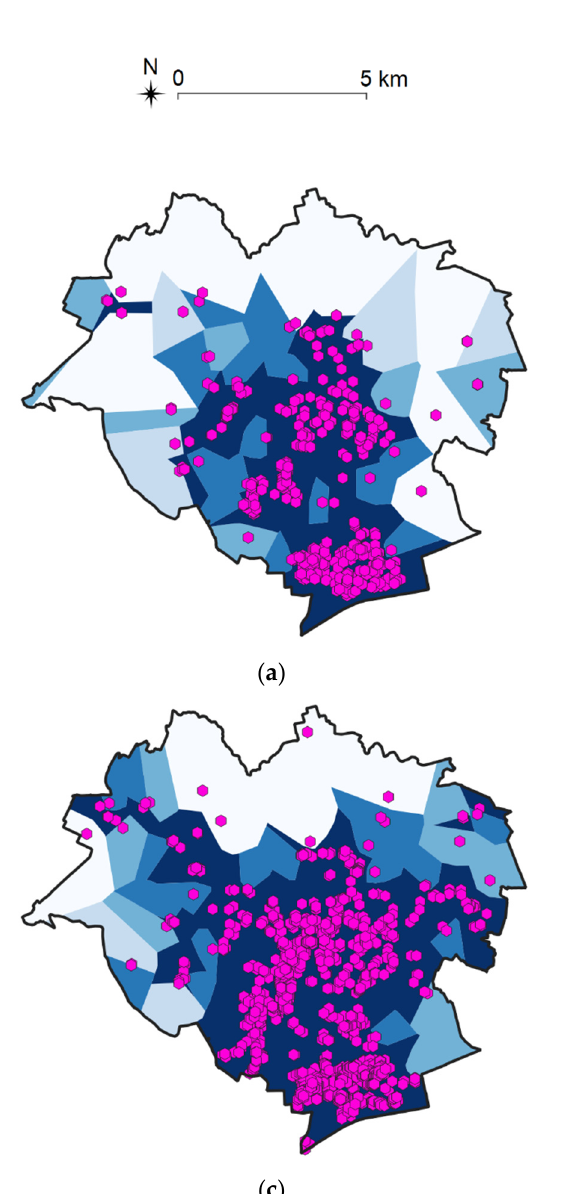
Figure 6. Spatial accessibility of selected public amenities in Olsztyn [units/km 2 ], part 2. Source: own elaboration. ( a ) Sports facilities; ( b ) Grocery stores; ( c ) Parking lots; ( d ) Public transport stops.